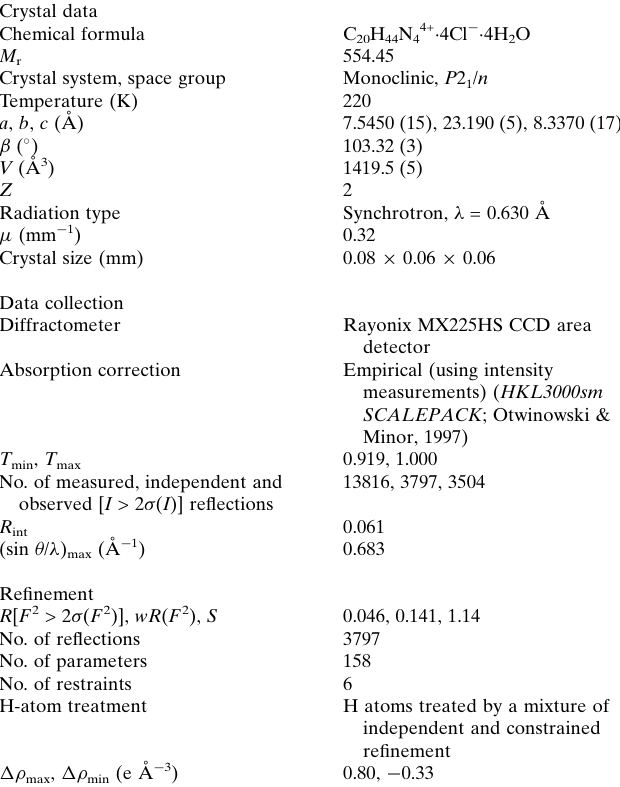
Table 2 Experimental details. Crystal data Chemical